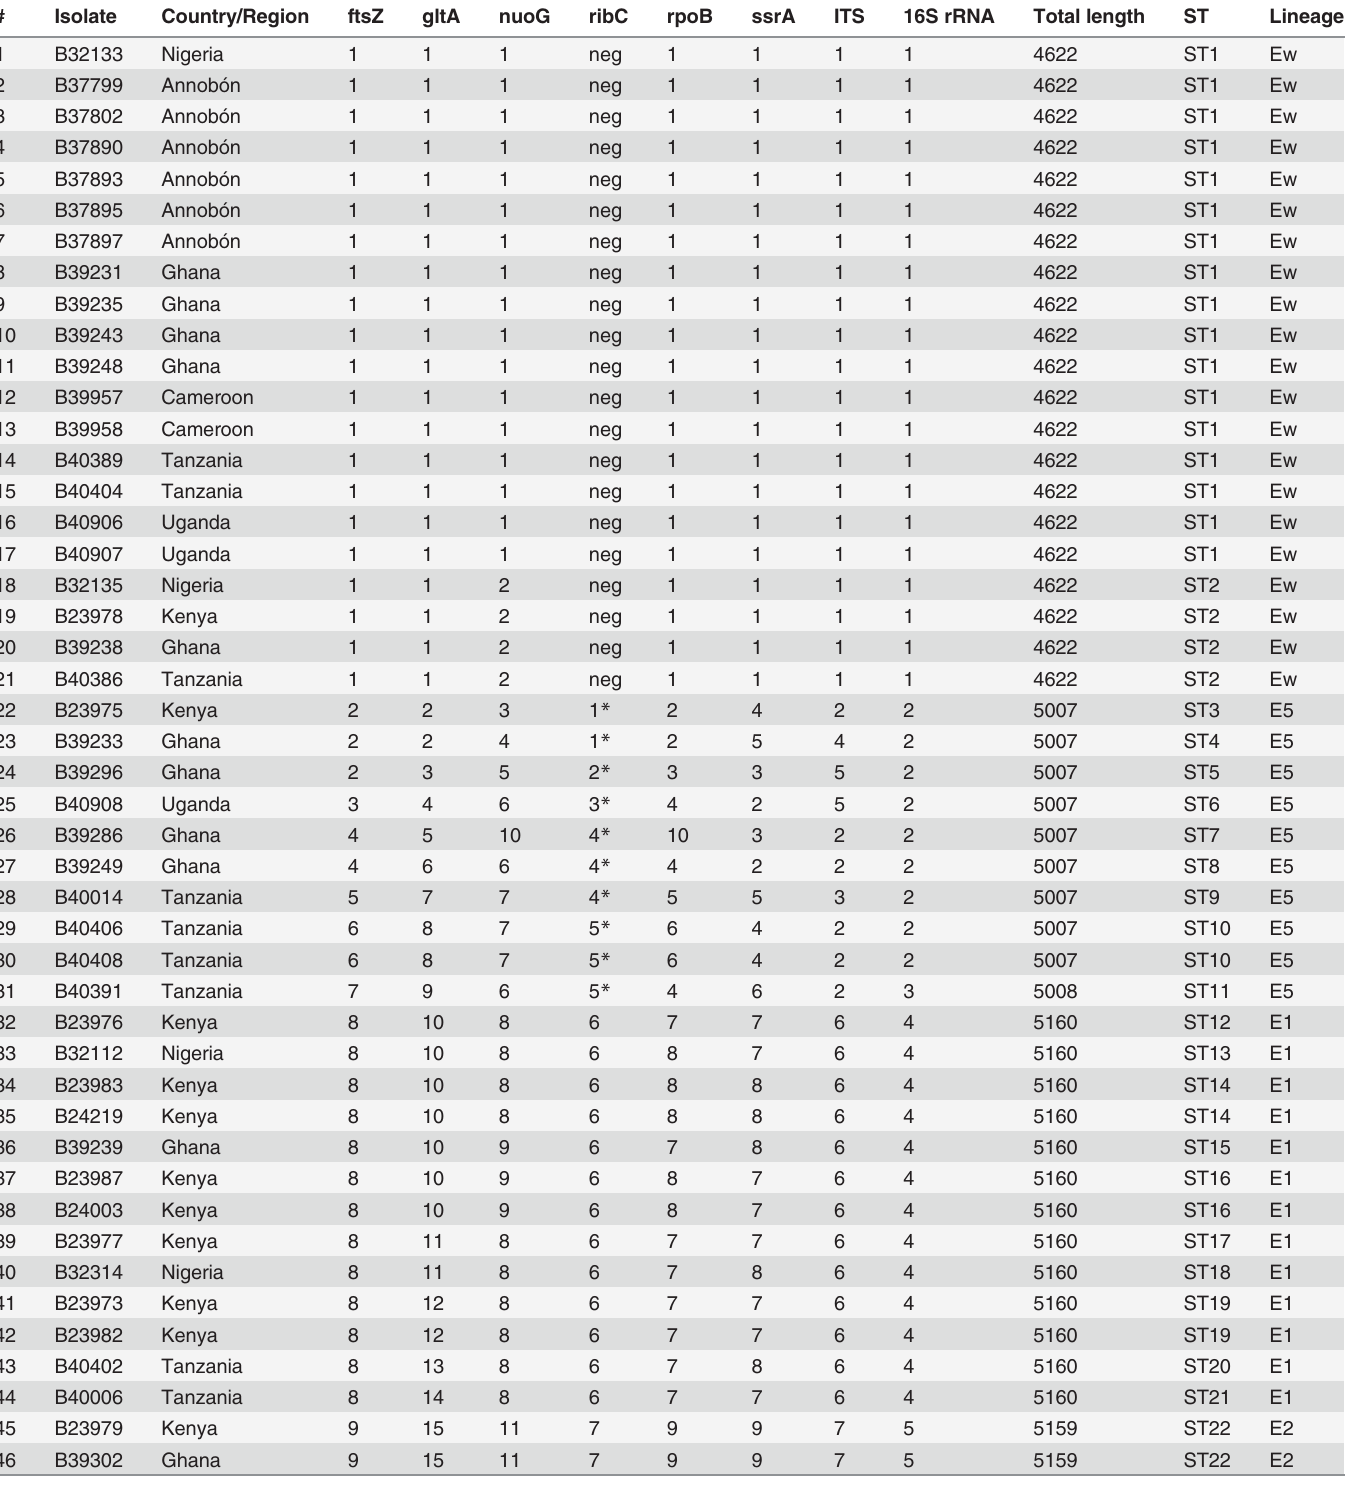
Table 1. Allelic pro fi les, sequence types (ST), and lineage identi fi cation for the 79 Bartonella isolates from different geographic